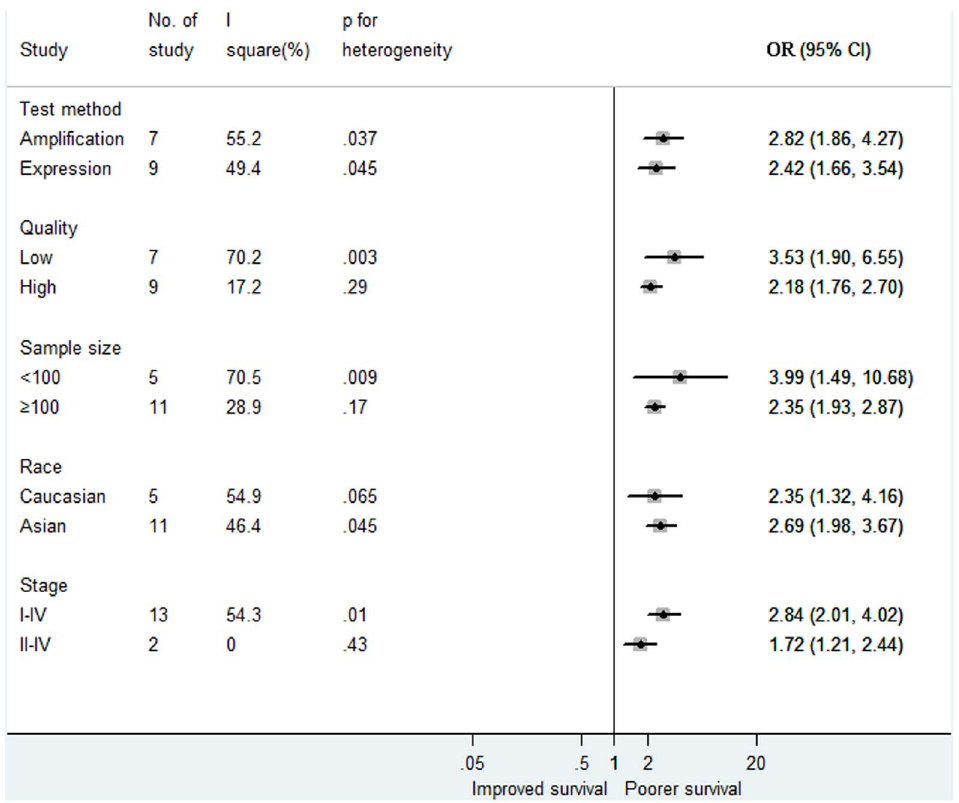
Figure 3. Effect of MET overexpression on gastric cancer by prespecified study characteristics in different subgroups. Weights are from random-effects analysis. Squares indicate the point estimates of the effect of disease (odds ratio) and diamonds, the summary estimate from the pooled studies; 95% confidence intervals are indicated by horizontal bars and shown in parentheses.